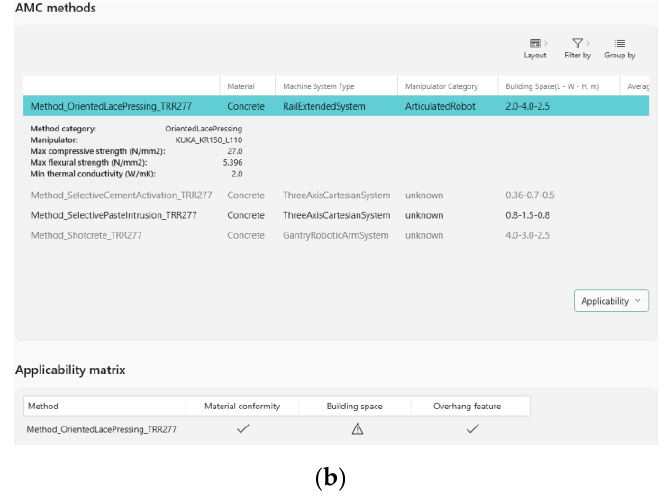
Figure 12. Prototype of the DDSS portal whose functionalities will be continuously extended. ( a ) Building component’s geometry and semantics received from the BIM toolkit. ( b ) AMC methods and evaluation results.